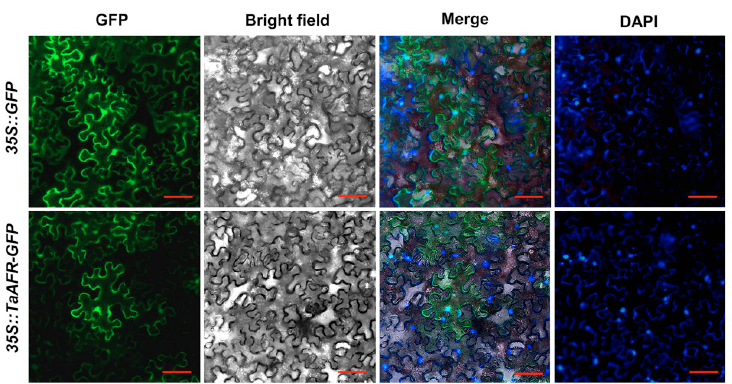
Fig 6. Fluorescence visualization of TaAFR subcellular localization in tobacco leaves. The free GFP protein and TaAFR-GFP fusion protein were transiently expressed in the N . benthamiana by Agtobacterium -mediated transformation. GFP, GFP fluorescent signal channel; Bright field, ordinary light channel; DAPI, nuclei were stained by DAPI; Merge, merge of GFP, Bright field and DAPI. Bar = 20 μ m.